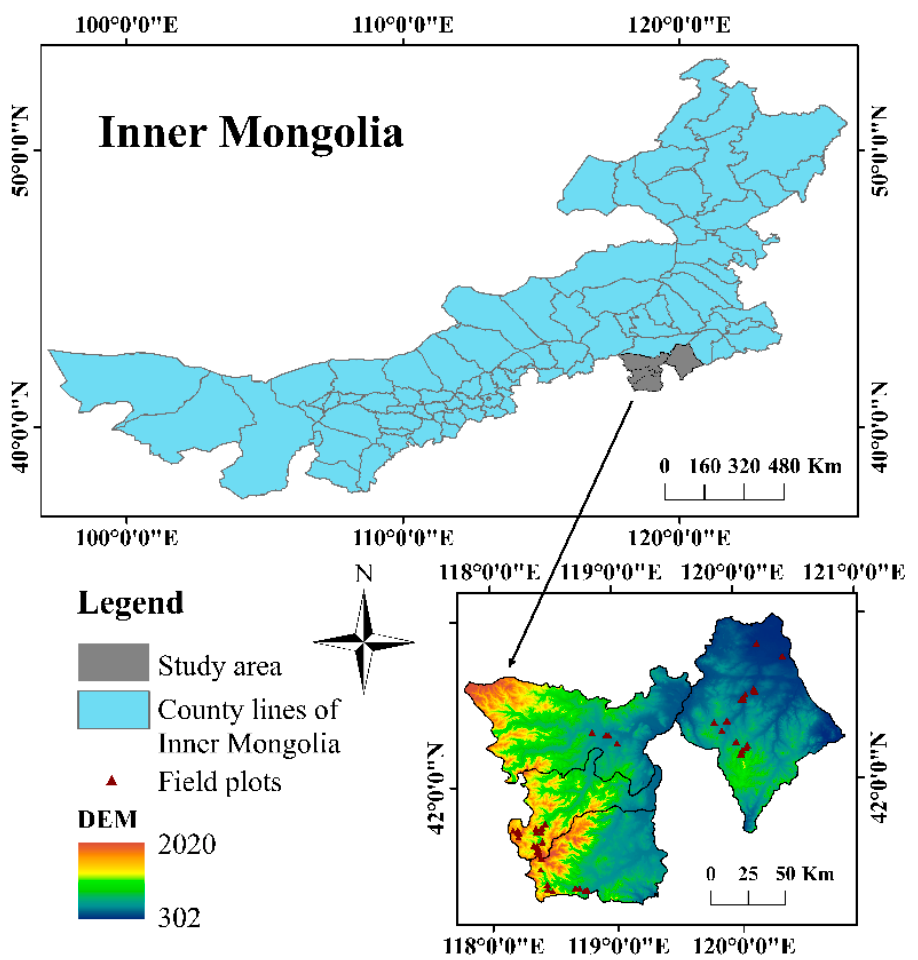
Figure 1. Overview of the study area and distribution of sampling sites.